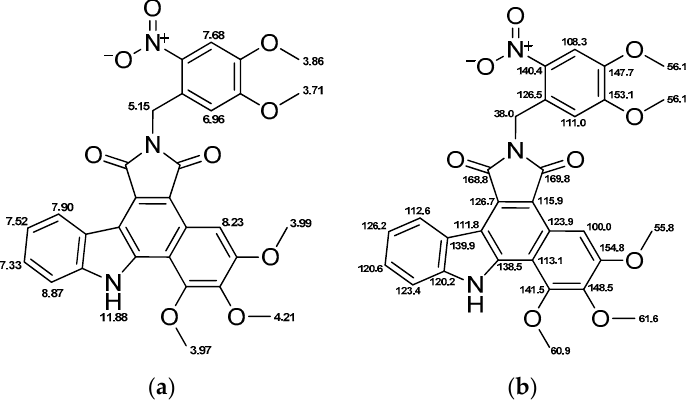
Figure 12. Chemical structure of 5 and relevant NMR shifts for ( a ) 1 H-NMR; and ( b ) 13 C-NMR.